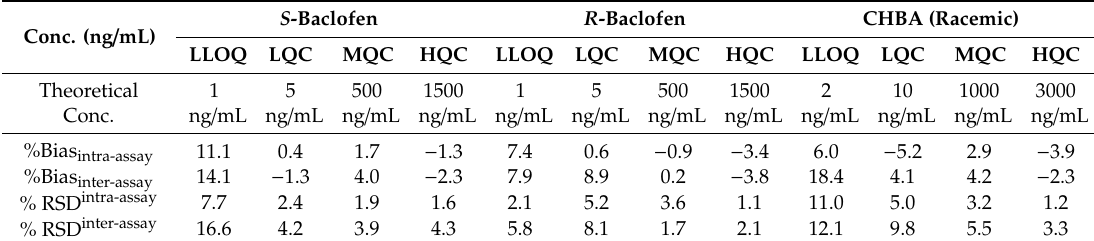
Table 2. Inter-day and intra-day accuracy (% bias) and precision (%RSD) for baclofen and its metabolite in human plasma. HQC: high-quality control, LLOQ: lower limit of quantification, LQC: low-quality control, MQC: middle-quality control.